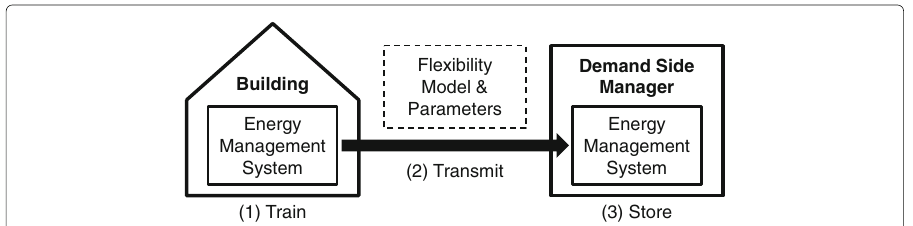
Fig. 1 Model and parameters representing the flexibility of one or multiple DERs in a building are communicated to the demand side manager (cf. (Förderer et al. 2018))